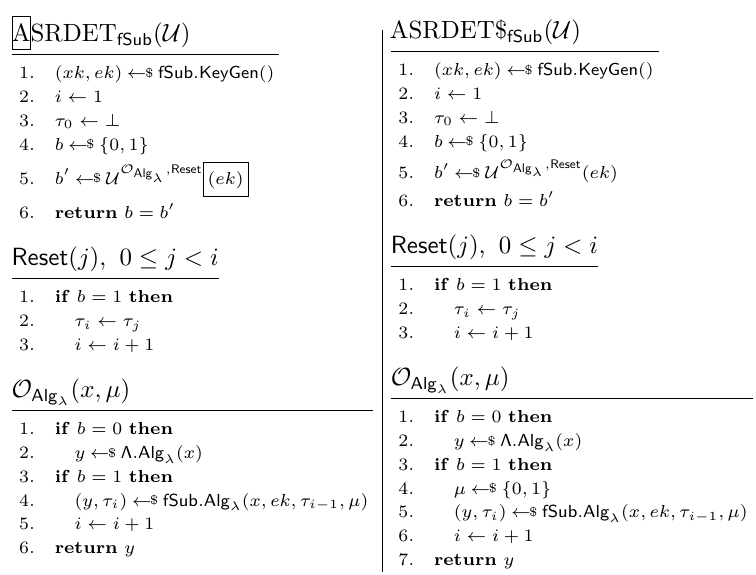
Figure 15: The regular and augmented state reset detection games for flexible ASAs is on the left, and the game ASRDET$ is on the right. The augmented game includes the code in the box, while the regular one does not. The ASRDET$ game is a modification that generates a random µ on each invocation of O instead of using the supplied Alg λ